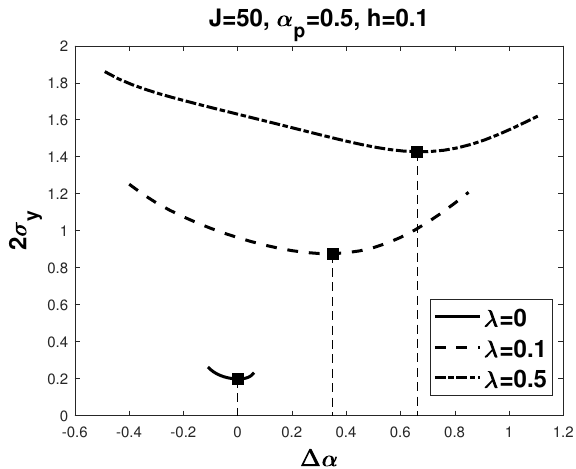
Figure 4. 2 σ y against ∆ α with limits on the control